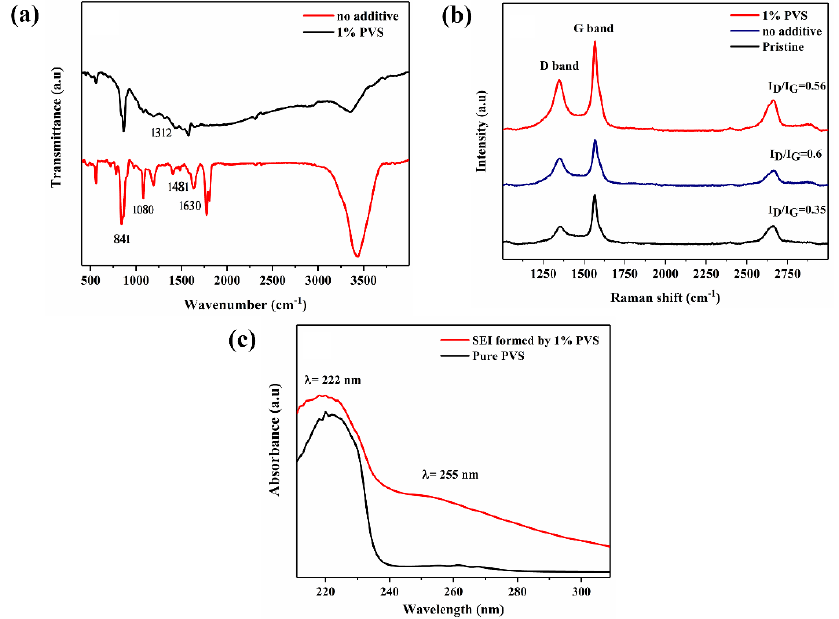
Figure 8. ( a ) The FT-IR spectra of the graphite electrodes after cycling in the electrolyte without and with the additive, ( b ) Raman spectra of the fresh and the cycled graphite electrodes in the electrolytes without and with the PVS, ( c ) UV-visible spectra of the PVS powder (pure PVS) and the SEI formed on the graphite electrode’s surface through the reduction of the